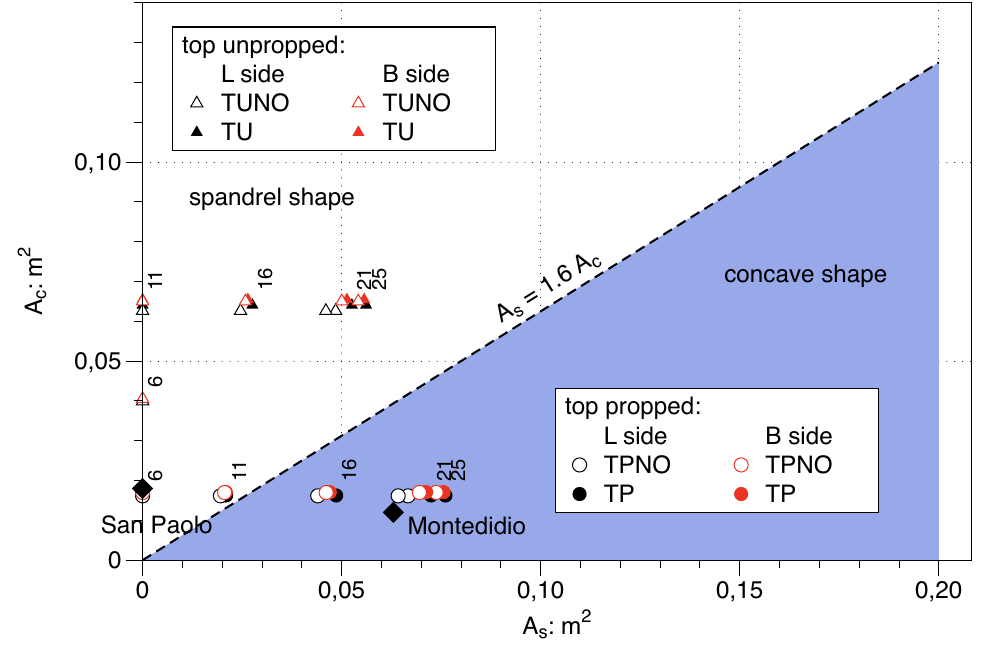
Figure 17. Areas of the horizontal displacement profiles of the embedded wall from FEM results: A c area of the cantilever portion of the displacement profile; A s difference between the total area and the cantilever portion.